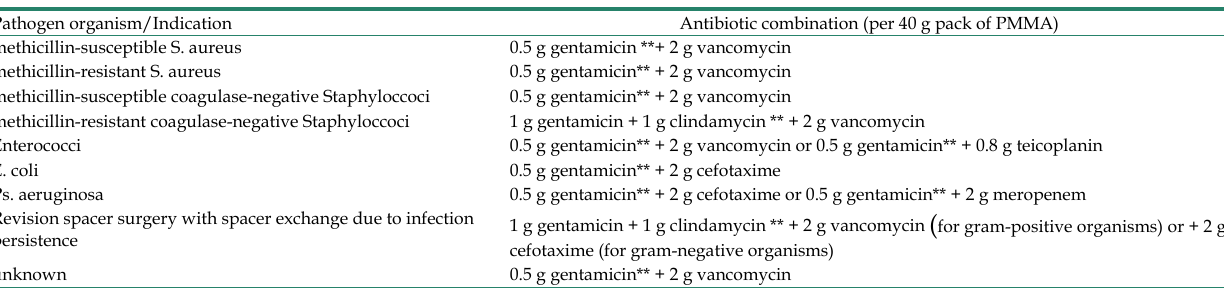
Table 1: Recommendations for antibiotic impregnation of acrylic bone cement spacers. Pathogen